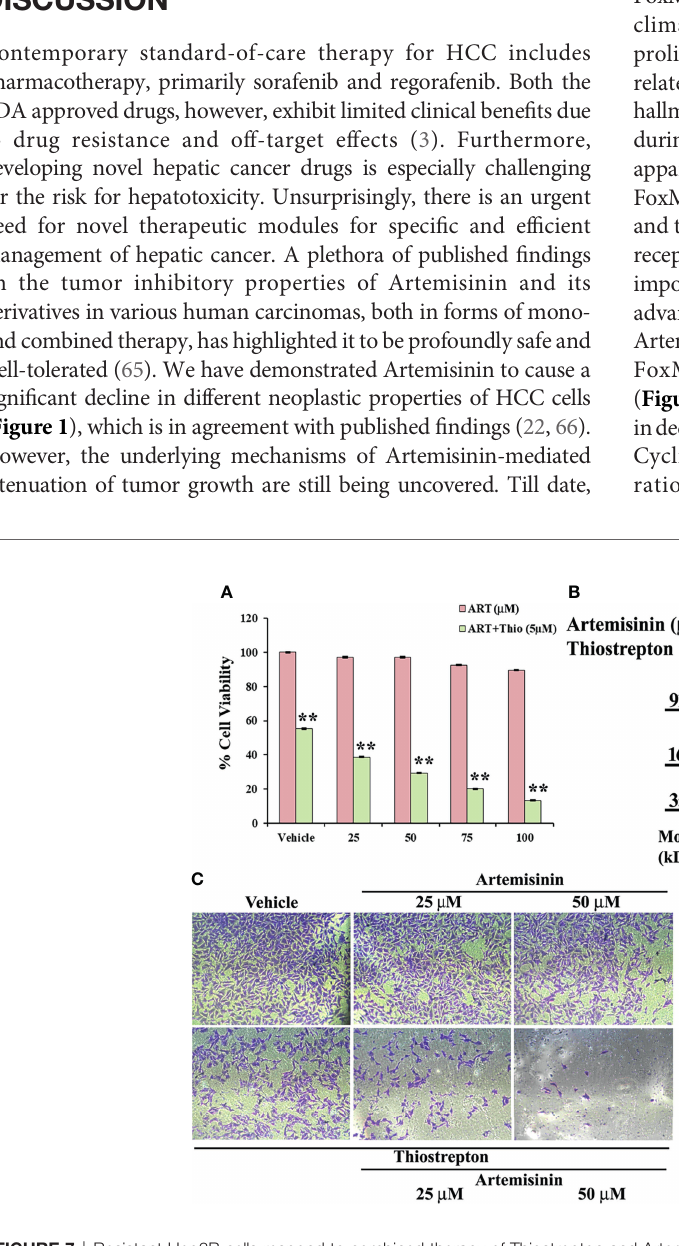
FIGURE 7 | Resistant Hep3B cells respond to combined therapy of Thiostrepton and Artemisinin. (A) Hep3B cells were treated with indicated doses of Artemisinin either alone or in combination with Thiostrepton for 48 h, followed by assessment of cell viability using MTT assay. (B) Hep3B cells were treated with Artemisinin alone (25 and 50 µM) or in combination with Thiostrepton for 48 h. Western blot analysis was carried out using antibodies for cleaved PARP and cleaved caspase 7. GAPDH served as a loading control. (C) Representative images of invading cells after matrigel invasion assay performed in Hep3B cells following exposure to Artemisinin alone or in combination with Thiostrepton are provided. (D) Bar graph depicting the number of invading cells. ** p < 0.01, and *** p < 0.001. All data are expressed as the means ± standard deviations from triplicate experiments. The two-tailed Student ’ s t -test was used to determine whether the differences between vehicle-treated set and Artemisinin-treated set were signi fi